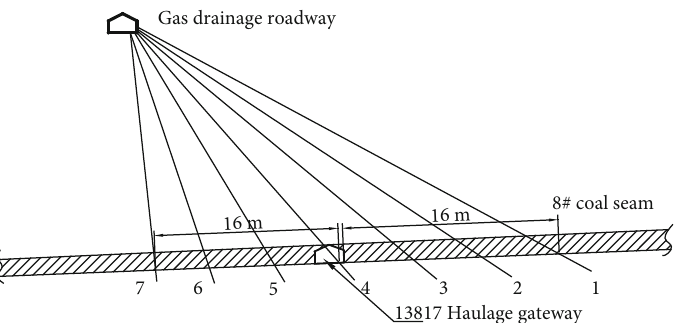
Figure 18: 13817 transport roadway heading face drainage borehole layout section.